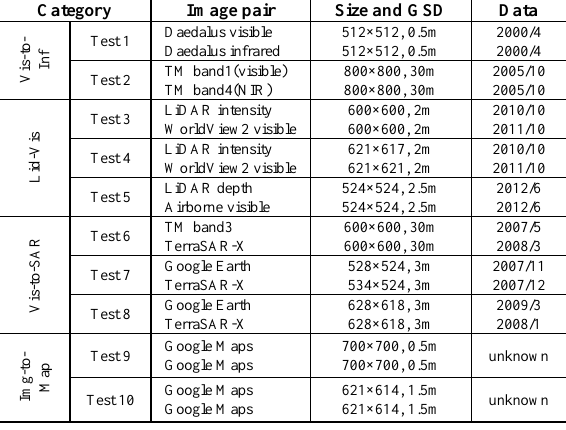
Table 1 Descriptions of the test